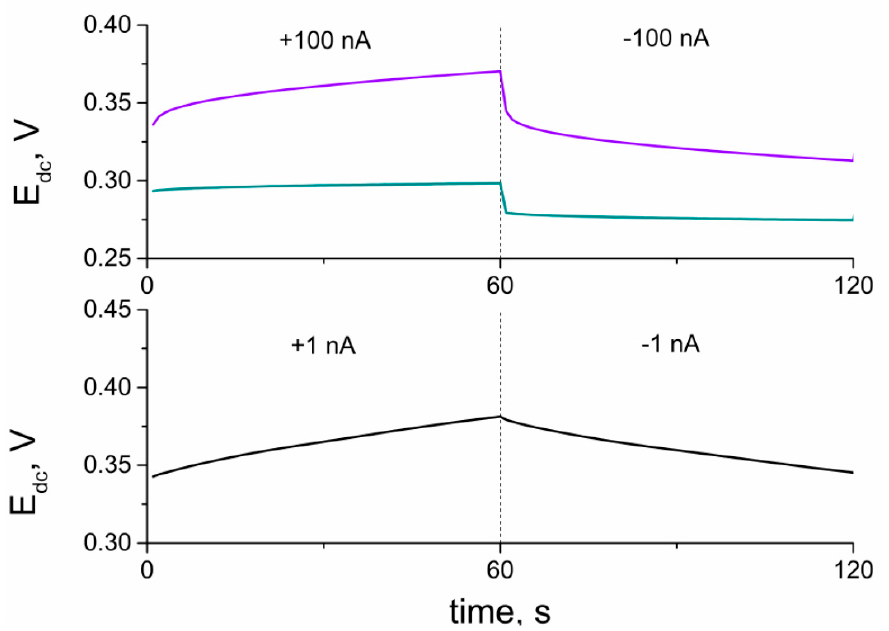
Figure 8. Capacitance values obtained for anhydrous (violet) and hydrous (blue) ruthenium dioxide dispersed in various solvents and applied in different amounts onto the electrode’s surface.